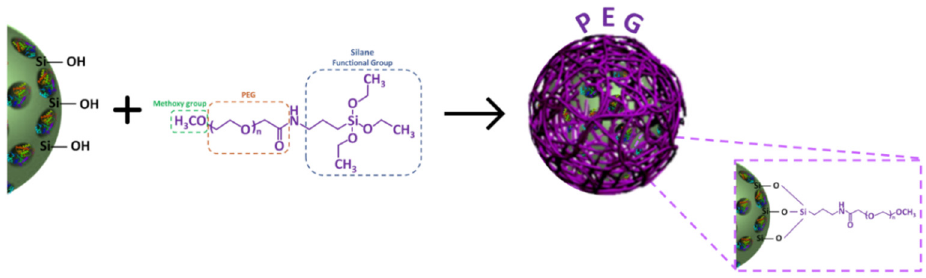
Figure 1. Schematic representation of the coating of mPEG-silane on LPMS_HRP obtained through PEGylation method.